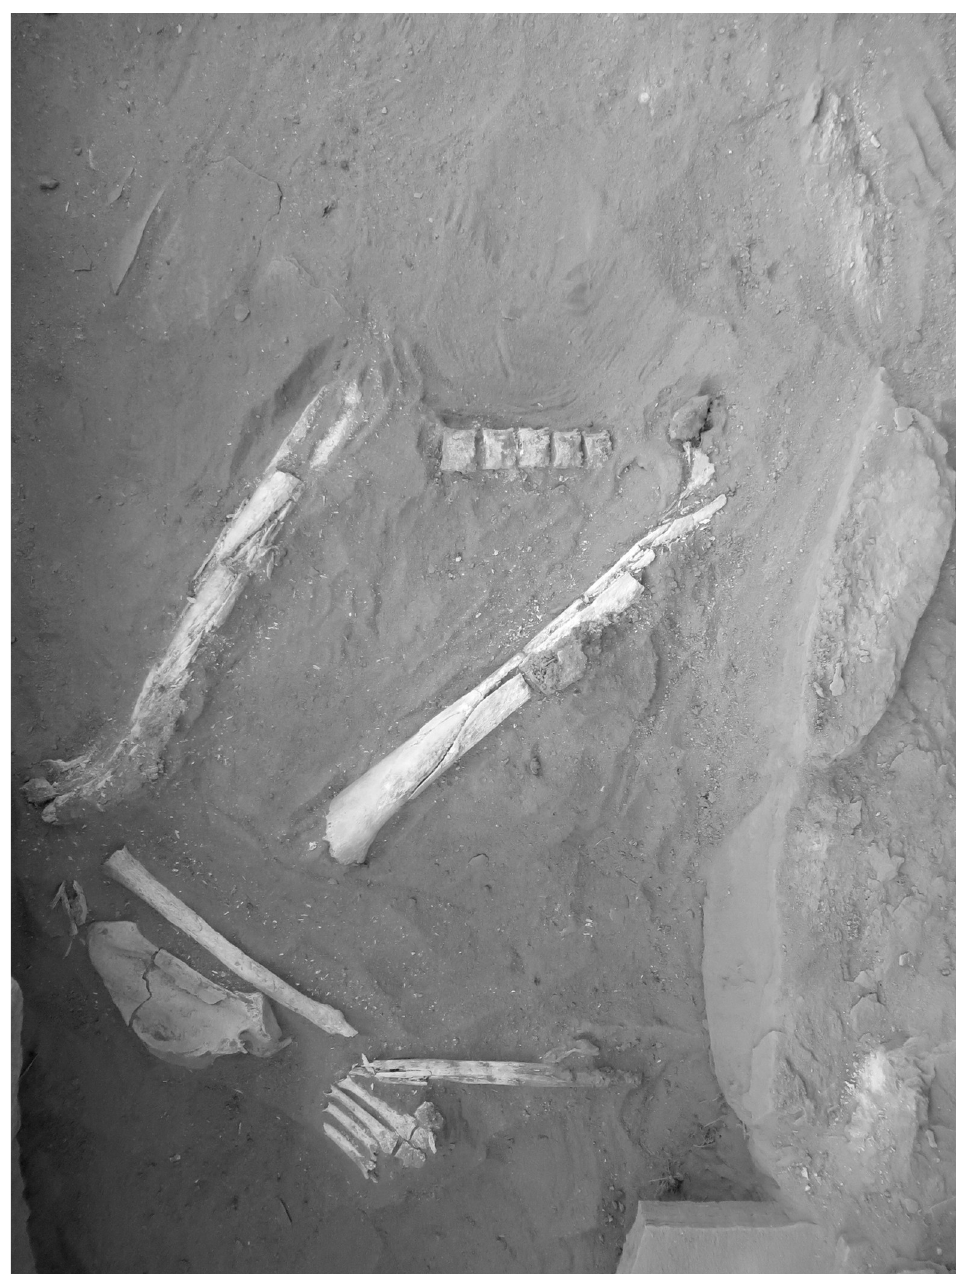
Fig 23. Detail of SK003, note the five thoracic